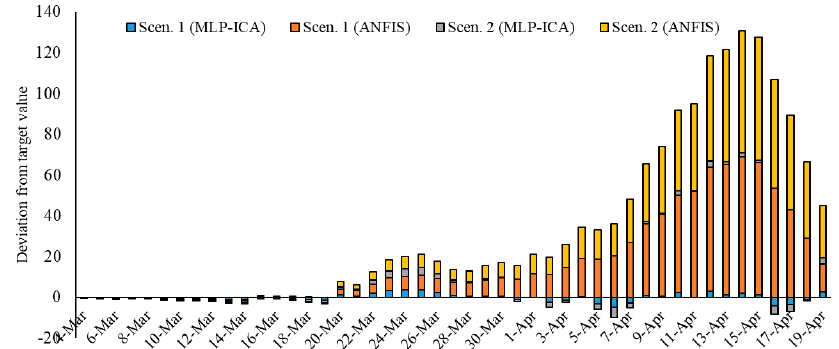
Figure 6. Deviation from target value (Cases).